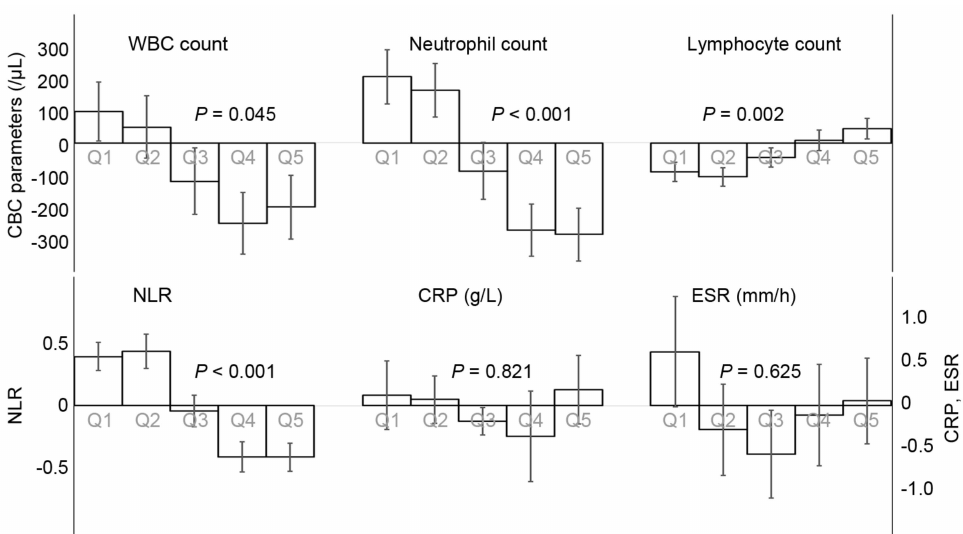
Figure 5. The changes in inflammatory markers according to the quintile of changes in natural killer cell activity. Each bar shows means and error bars express standard errors of means. p values were calculated using ANOVA tests. CBC, complete blood count; WBC, white blood cell; NLR, neutrophil-to-lymphocyte ratio, CRP, C-reactive protein; ESR, erythrocyte sedimentation